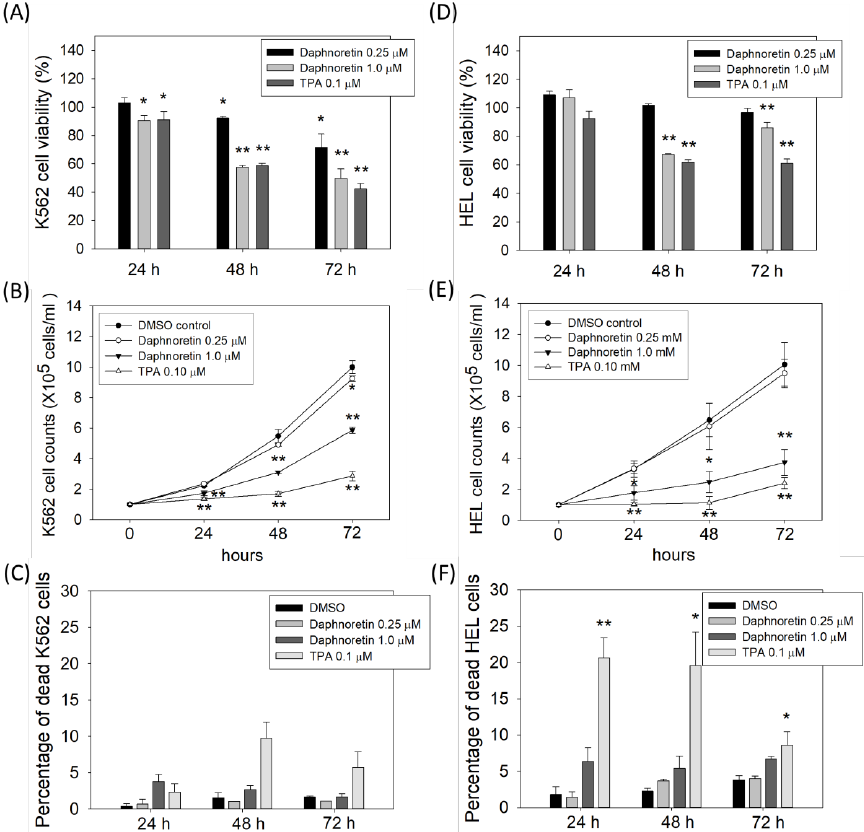
Figure 1. Effect of daphnoretin on the growth of K562 and HEL cells. Cells were treated with DMSO or 0.25, 1 µ M daphnoretin, 0.1 µ M TPA after 24–72 h. ( A , D ) Cell viability was determined using CCK-8 assay. The data represent the mean ± SD of three independent experiments, and the ratio of cell viability was presented as 100% in the DMSO group. * p < 0.05, ** p < 0.01 vs. DMSO-treated sample (ANOVA test followed by Dunnett’s post-hoc test). ( B , E ) The number of viable cells was counted using trypan blue exclusion assay. The data represents the mean ± SD of three independent experiments * p < 0.05, ** p < 0.01 vs. DMSO-treated sample (ANOVA test followed by Dunnett’s post-hoc test). ( C , F ) The percentage of dead cells was determined using trypan blue exclusion assay. The data represents the mean ± SD of three independent experiments * p < 0.05, ** p < 0.01 vs. DMSO-treated sample (ANOVA test followed by Dunnett’s post-hoc